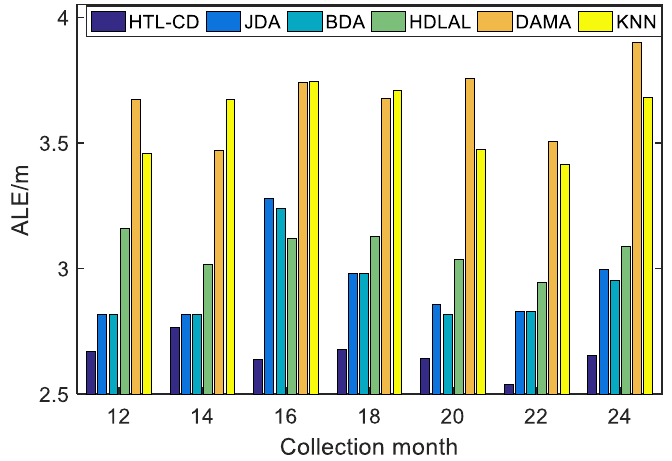
Figure 5. Comparison of the positioning performances with partially different APs. Case 2: positioning with totally different